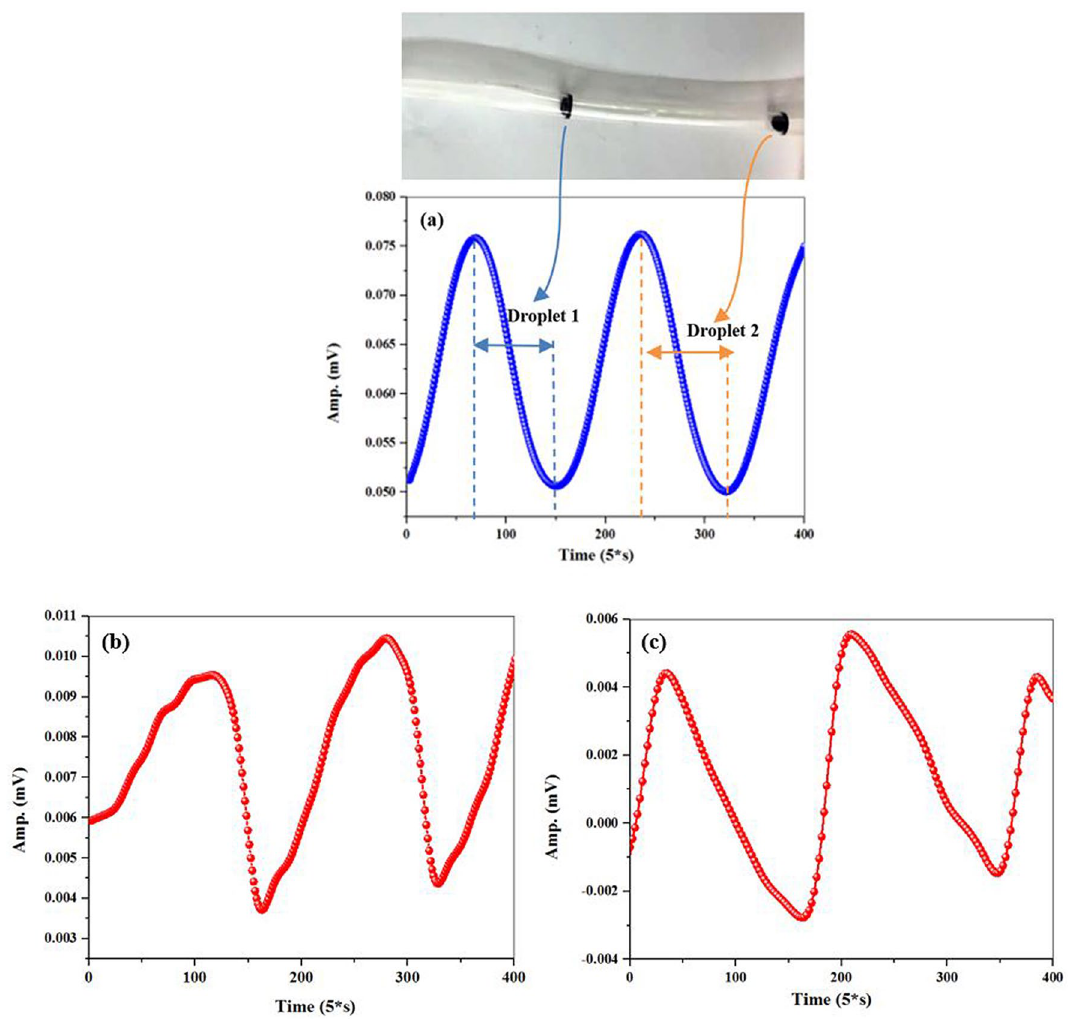
Figure 6. ( a ) The signal related to detection of two magnetic droplets through the arterial vessel phantom ( a ) without stenosis, ( b ) with a 7 mm stenosis, and ( c ) with a 14 mm